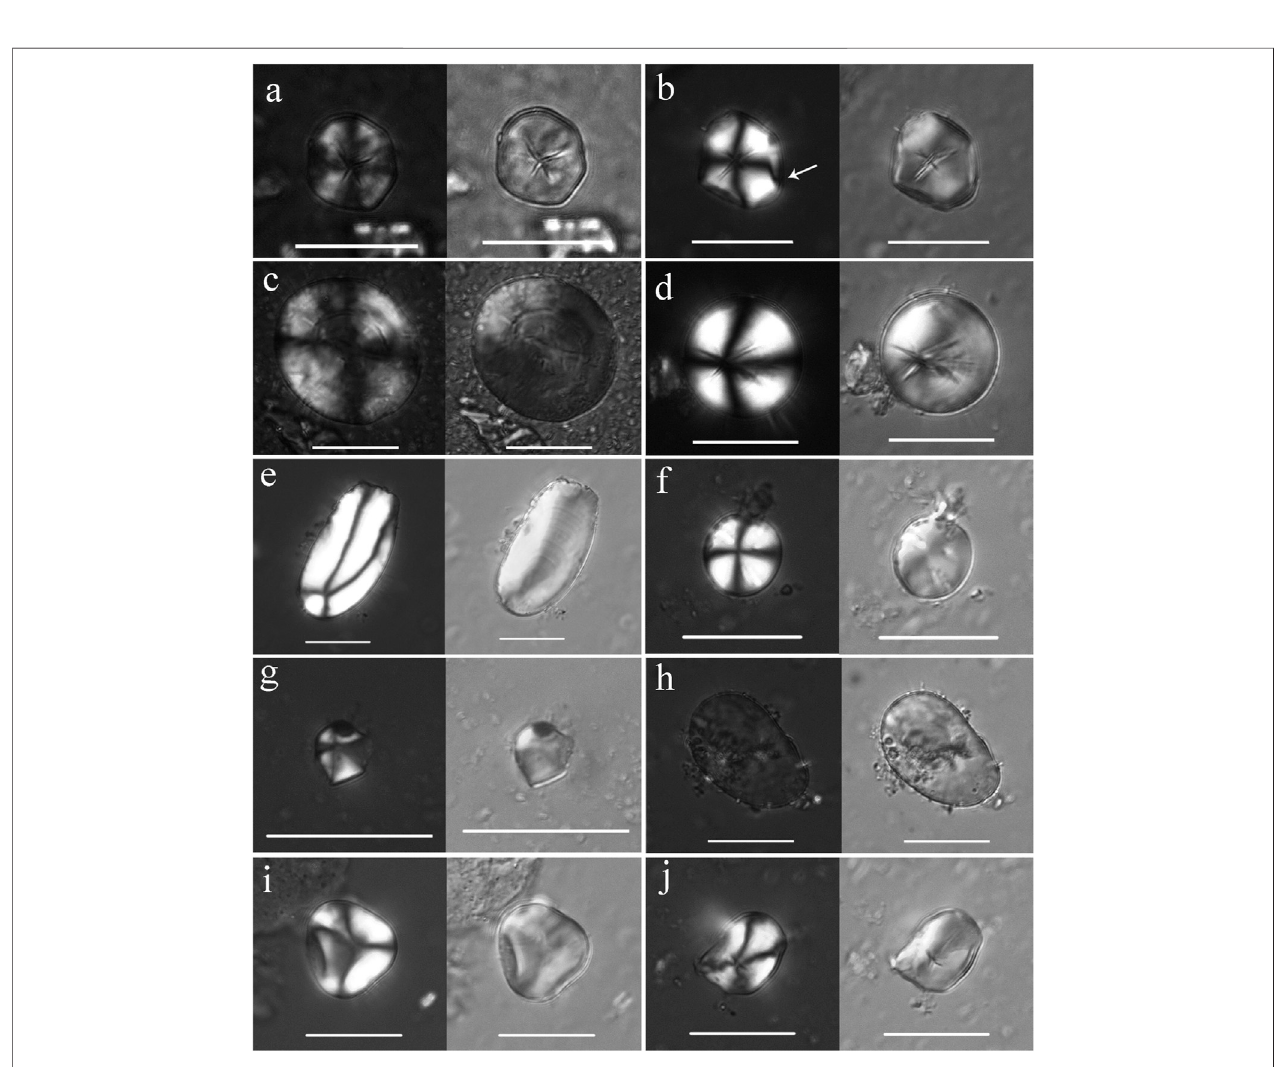
FIGURE 5 | Types of starch grains at the Qingtai site (scale bar: 20 μ m). (A) Setaria italica ; (B) Coix lacryma-jobi ; (C) Triticeae; (D,E) Nelumbo nucifera ; (F) Trichosanthes kirilowii; (G) Oryza sativa ; (H) Leguminosae; (I) Quercus sp.; (J) tubers.